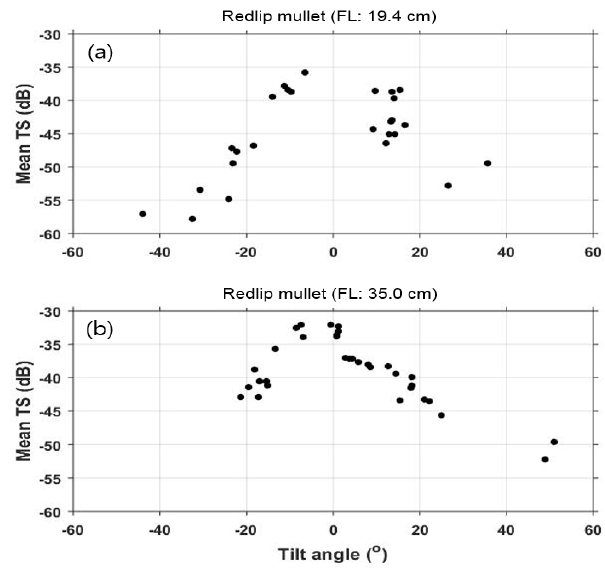
Figure 8. Variation between the tilt angle and mean target strength ( TS ; dB) of mullet at 200 kHz [( a ) 19.4 cm fish total fish length ( FL ), and ( b ) 35.0 cm in FL ].